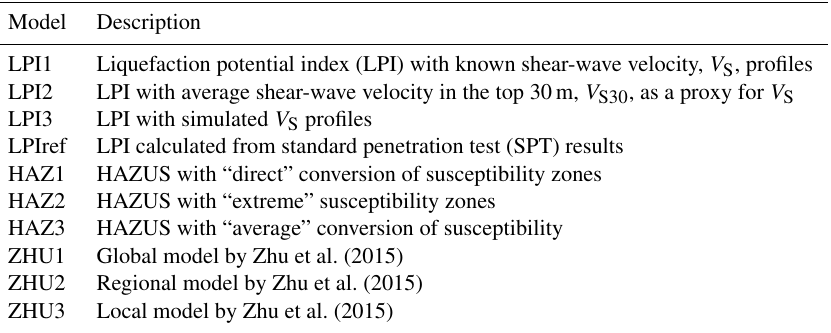
Table 4. Liquefaction forecasting models compared in this